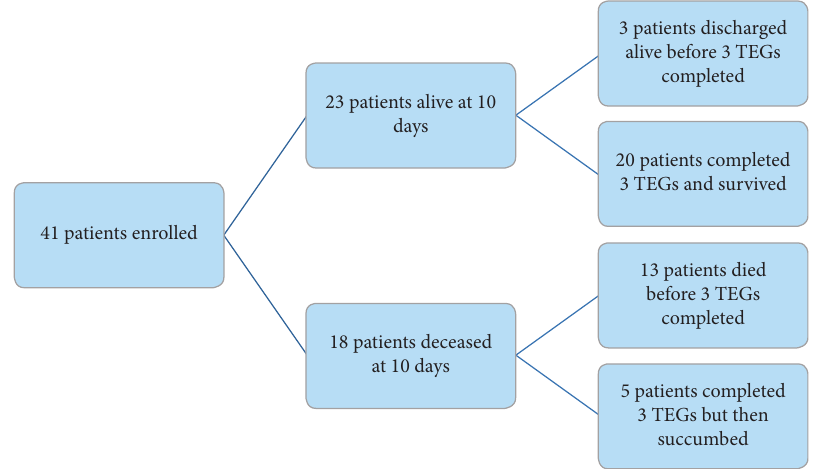
Figure 1: Flow diagram of a number of TEGs